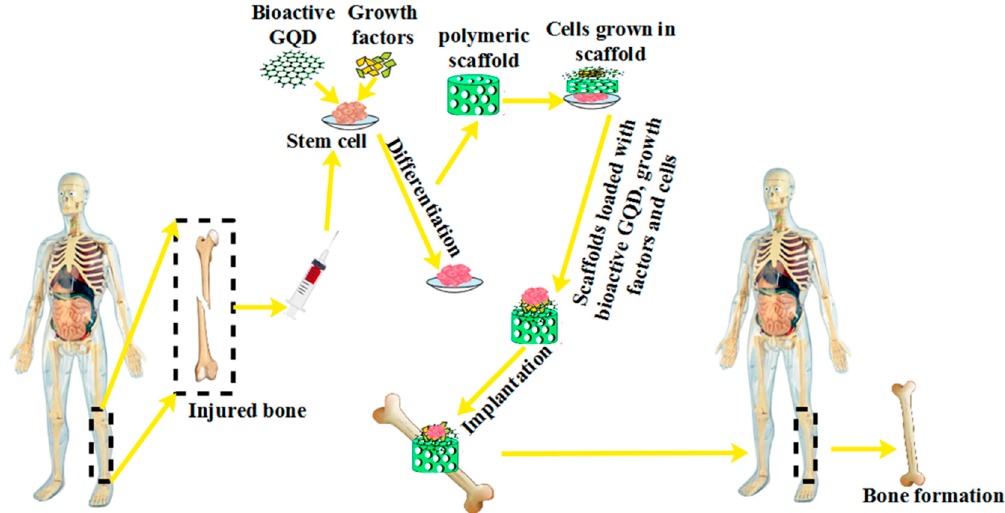
Figure 12. The important role of bioactive GQDs in damaged bone formation in tissue engineer- ing.